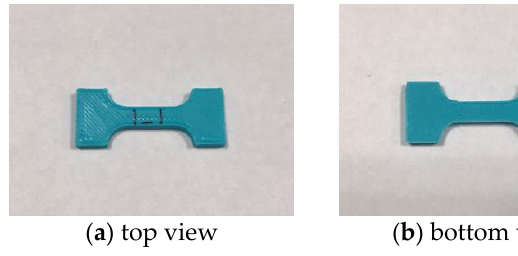
Figure 4. Parts after printing. Table 4. Mean values and S/N ratios of the experimental results.